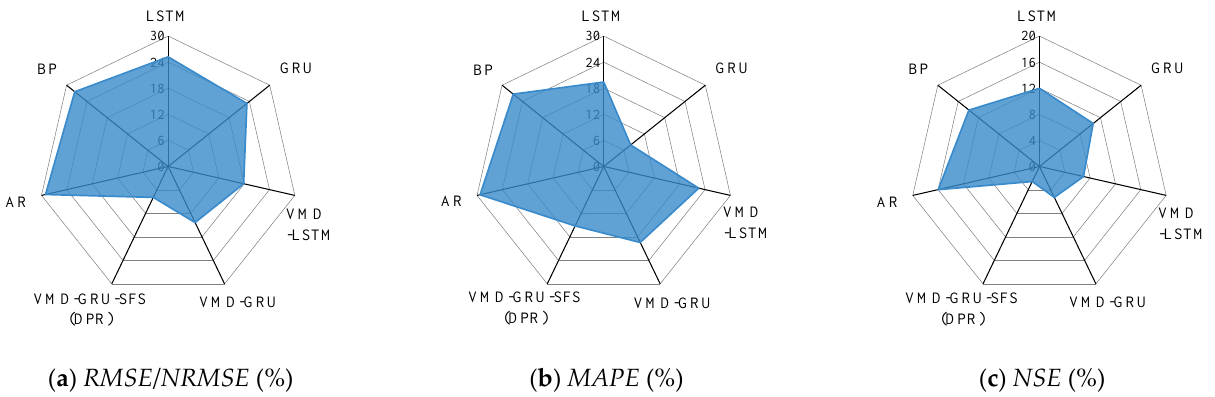
Figure 10. Improvement rates in terms of statistical indexes in the testing stage of the proposed method for runoff forecasts at the Yichang station, as compared with the different models. ( a ) RMSE / NRMSE improvement rate; ( b ) MAPE improvement rate; ( c ) NSE improvement rate.